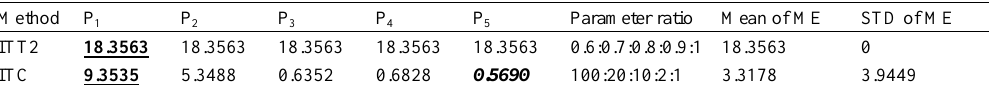
Table 2. Result of square in experiment 1.